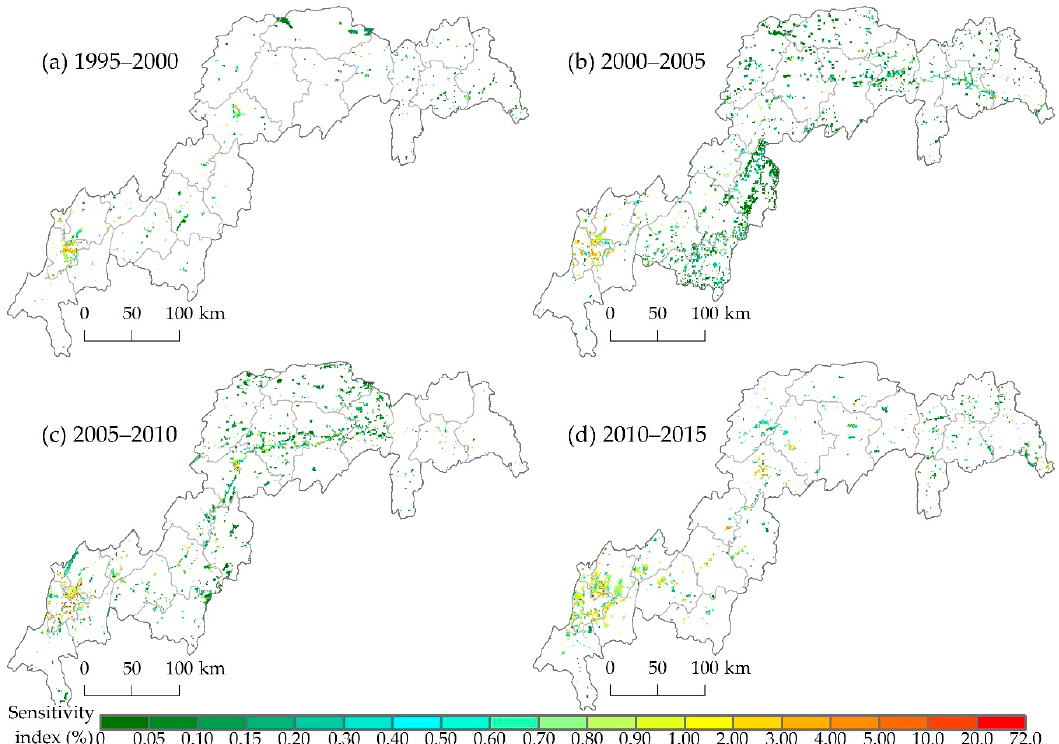
Figure 8. Spatial patterns of the sensitivity index of soil conservation service value (SCSV) changes in response to land use/cover change (LUCC) in Three Gorges Reservoir Area, for the periods ( a ) 1995–2000, ( b ) 2000–2005, ( c ) 2005–2010, and ( d ) 2010–2015. No LUCC occurred in the blank (white) areas.